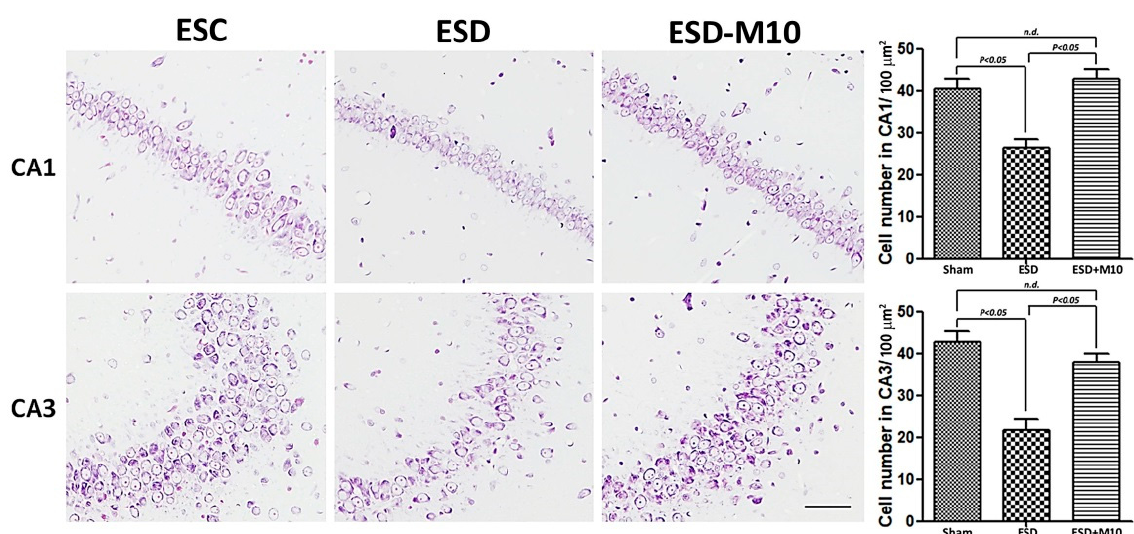
Figure 7. Photomicrographs and histogram show the results of Nissl staining of hippocampal neurons. There were decreases in cell density in CA1 and CA3 following ESD. Staining intensity increased with melatonin treatment. The histogram shows the quantification of the hippocampal CA1 and CA3 neurons. Nissl stained hippocampal neurons significantly increased in ESC and ESD-M10 groups when compared with ESD group ( p < 0.05). Scale bars: 100 μ m.